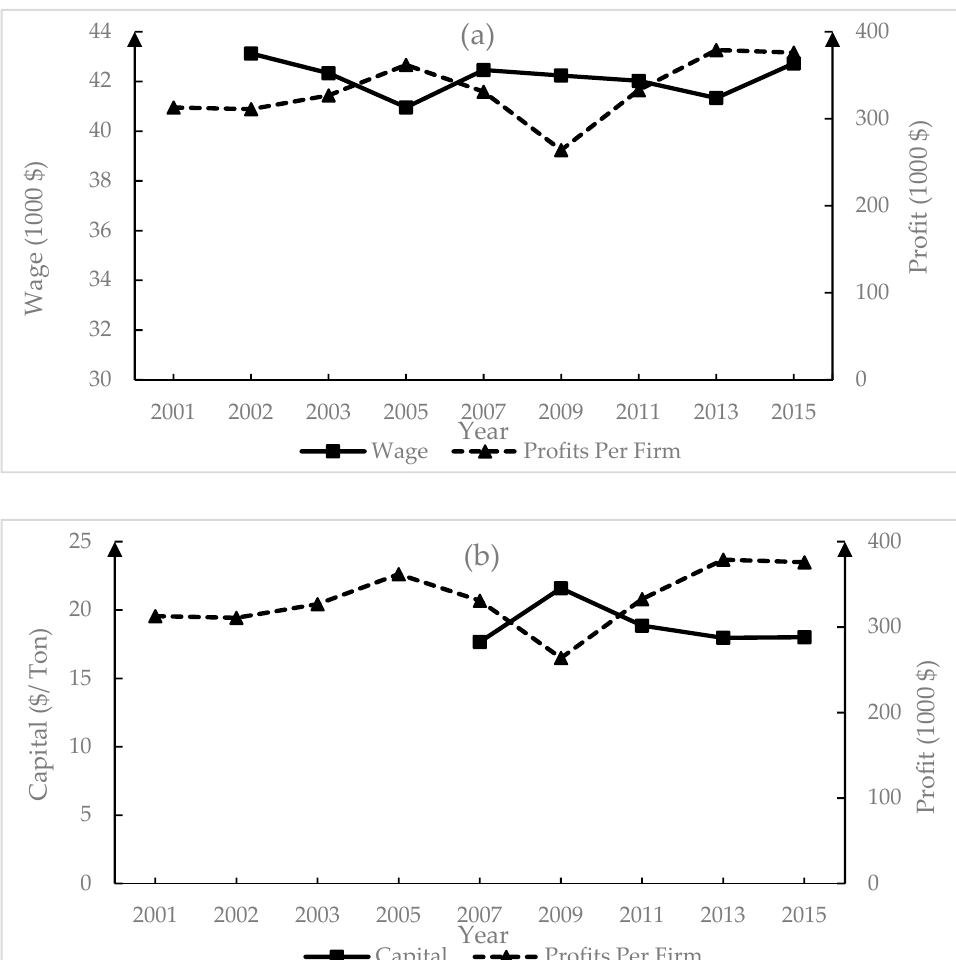
Figure 7. Inflation-adjusted profit per firm ( a ) annual wage and ( b ) capital stock per ton production (2019 Constant-dollar), 2001 to 2015 [38,77].